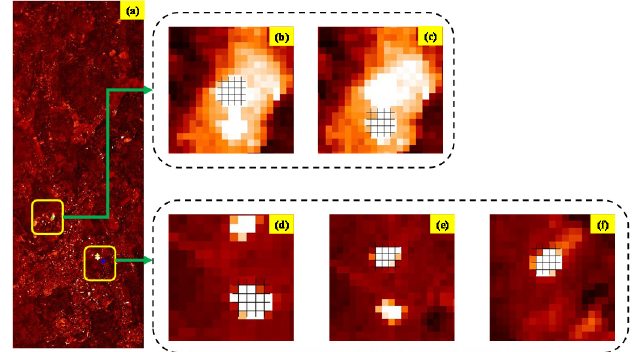
Figure 6. Target detection score image from ( a ) airborne imagery using in-situ reference target spectra, and the enlarged detection score footprint for ( b ) N3Y, ( c ) N4B, ( d ) N1G, ( e ) N2R, and ( f ) C1W target (In all the target detection score images, a brighter pixel indicates a higher target detection score and thus a higher probability for it to be declared as a target).